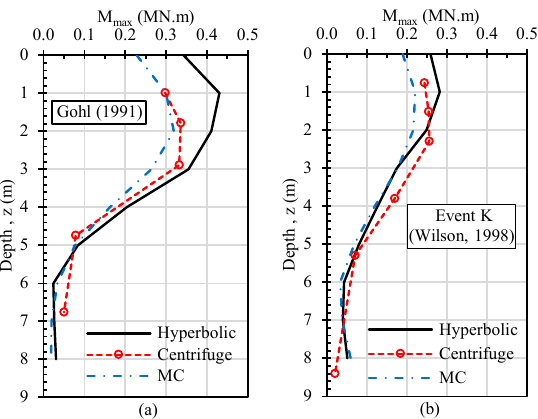
Figure 9. Bending moment variation with depth for verification analyses (Case 1): ( a ) Gohl [30] and ( b ) Wilson [31] (Event K).